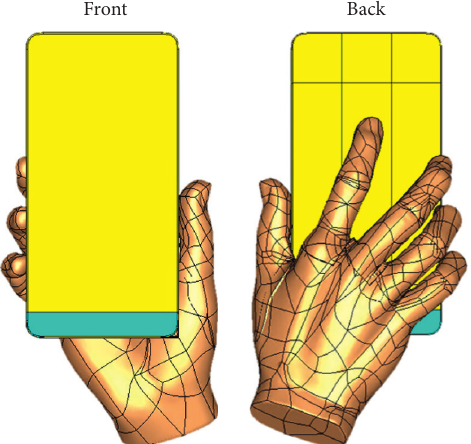
Figure 7: Front and back view of the hand